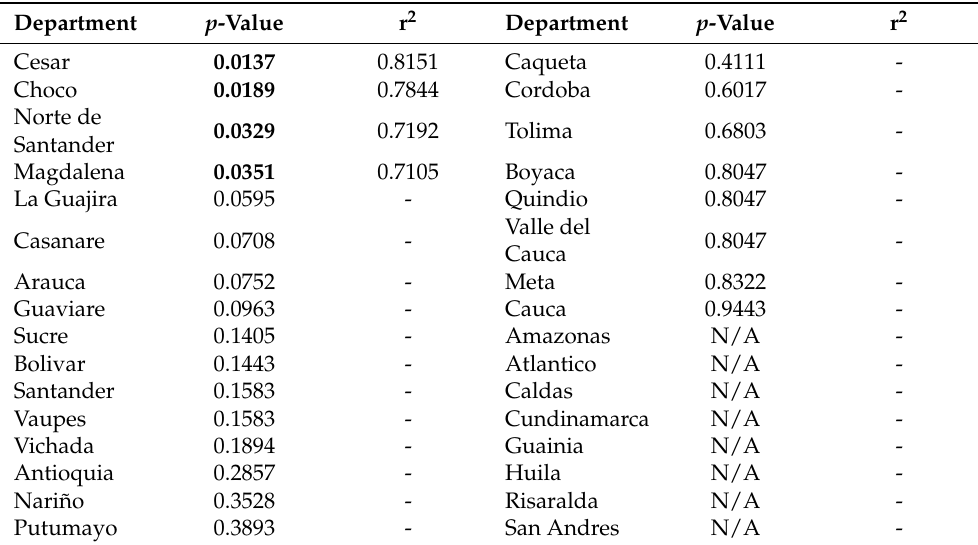
Table 1. Variation in bovine rabies cases by department, Colombia, 2014-2019, assessed by linear regression models.